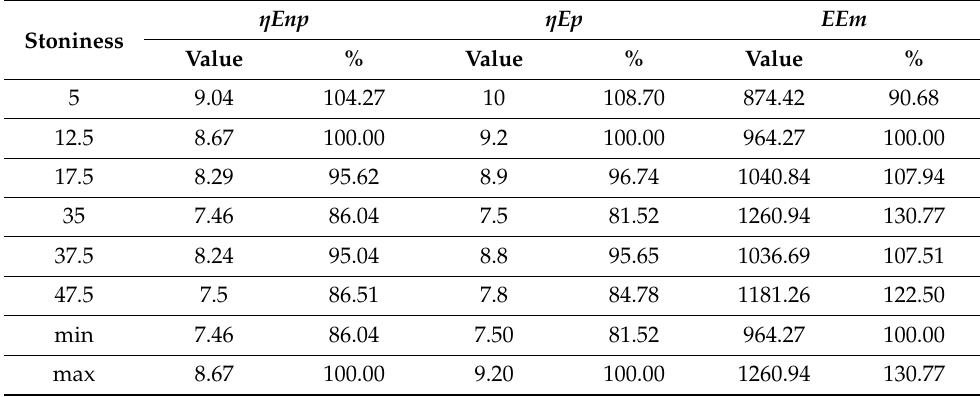
Table A13. Average emissions and efficiency of crops according to the stoniness.